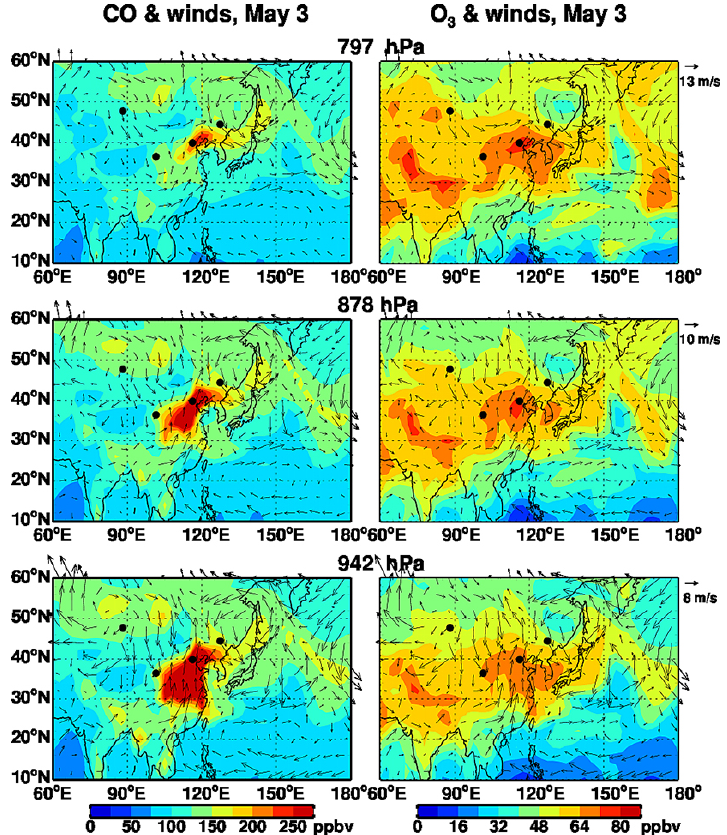
Figure 12. Same as Fig. 11, but for 3 May 2005.